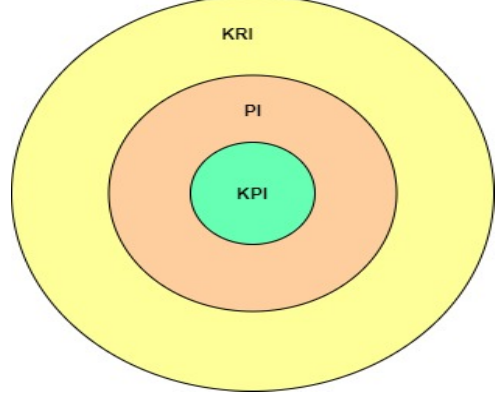
Figure 3. KPI onion mode.